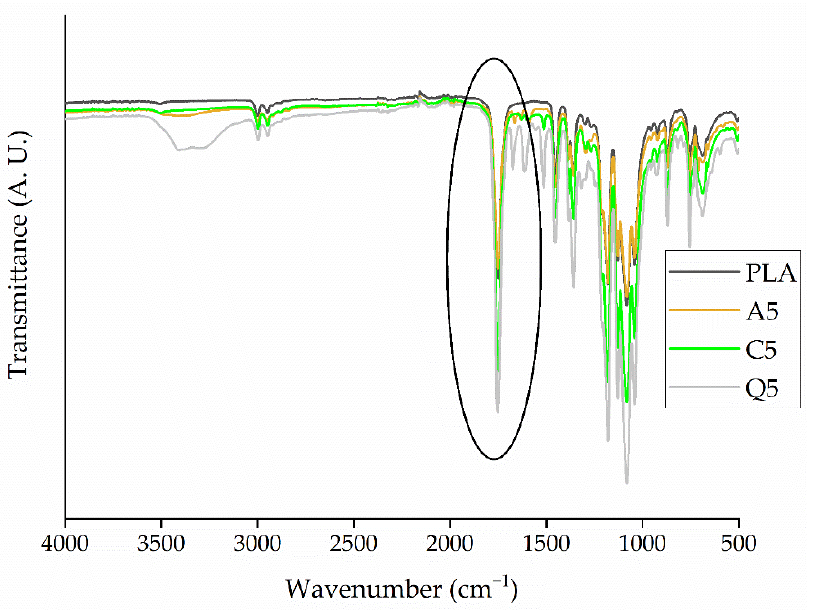
Figure 10. FTIR spectra of pure PLA and its composites containing 5% ( w / w ) of alizarin (A5), curcumin (C5), or quercetin (Q5).